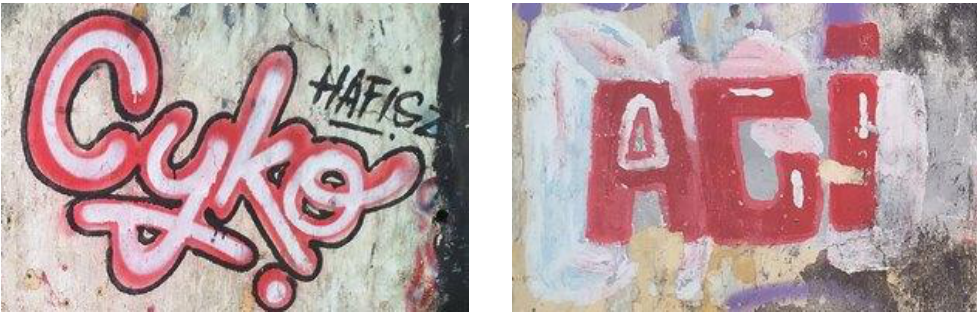
Figure 3 Samples of tagging and single